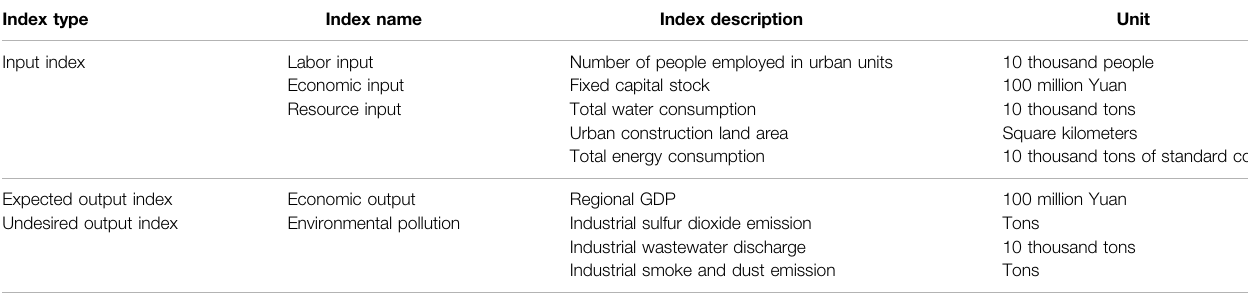
TABLE 2 | Evaluation index system of ecological ef fi ciency in Yellow River Basin.